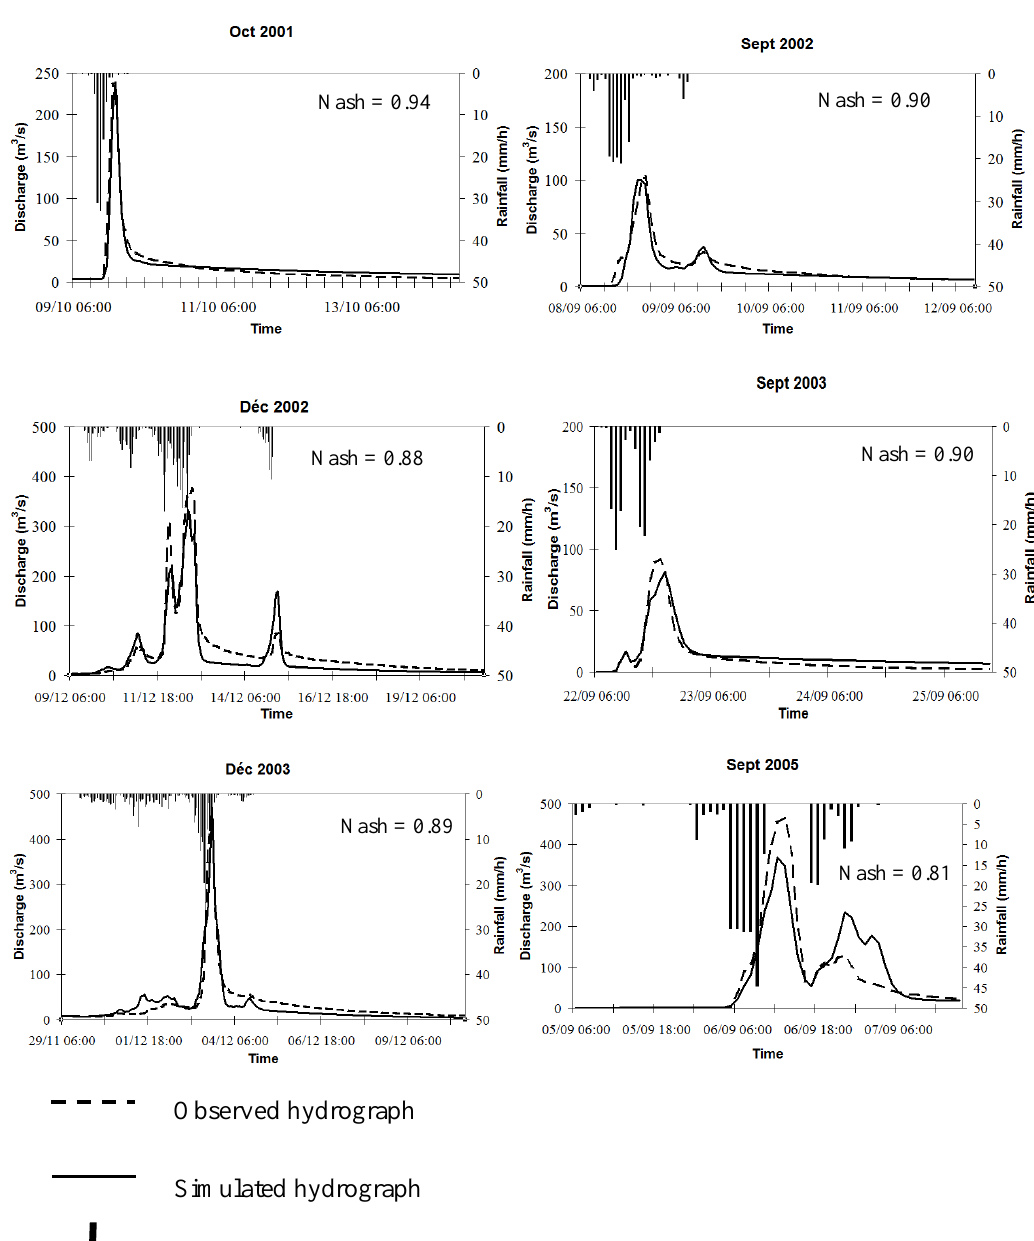
Fig. 5. Simulated and observed hydrographs for six major flood Figure 5: Simulated and observed hydrographs for six major events 8